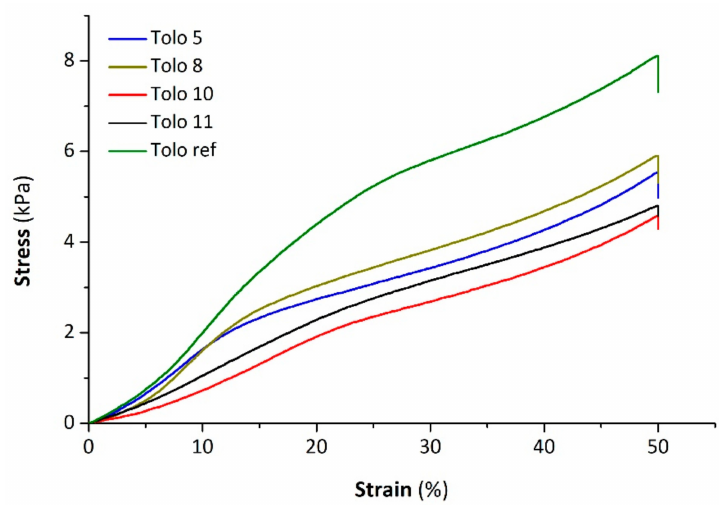
Figure 12. Stress–strain curves of PU